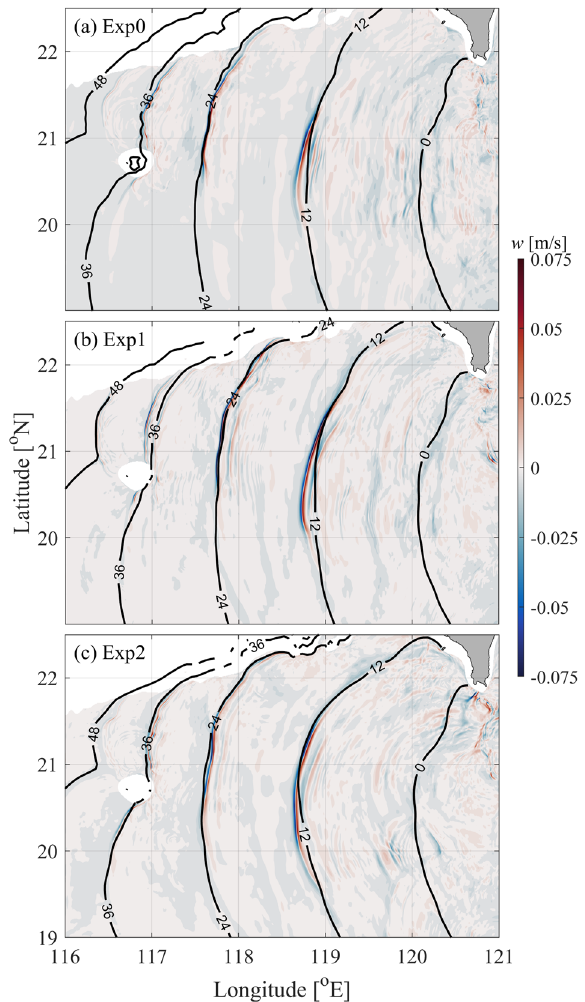
Figure 6. Snapshots of vertical velocity (shadings, units: m/s) at z = -150 m for ( a ) Exp0, ( b ) Exp1 and ( c ) Exp2. The black lines show the wavefronts derived from the wavefront tracing model considering U and N , noting that the U = 0 in